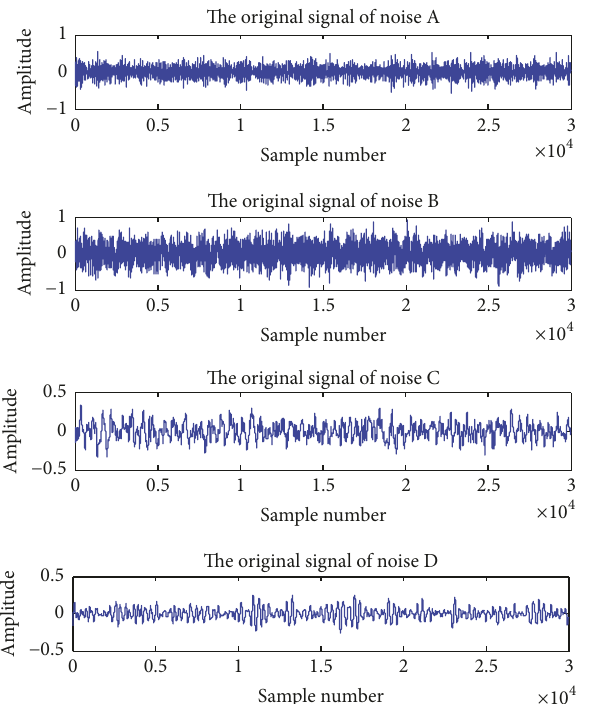
Figure 3: The time domain waveform of real ship radiated noise signals.